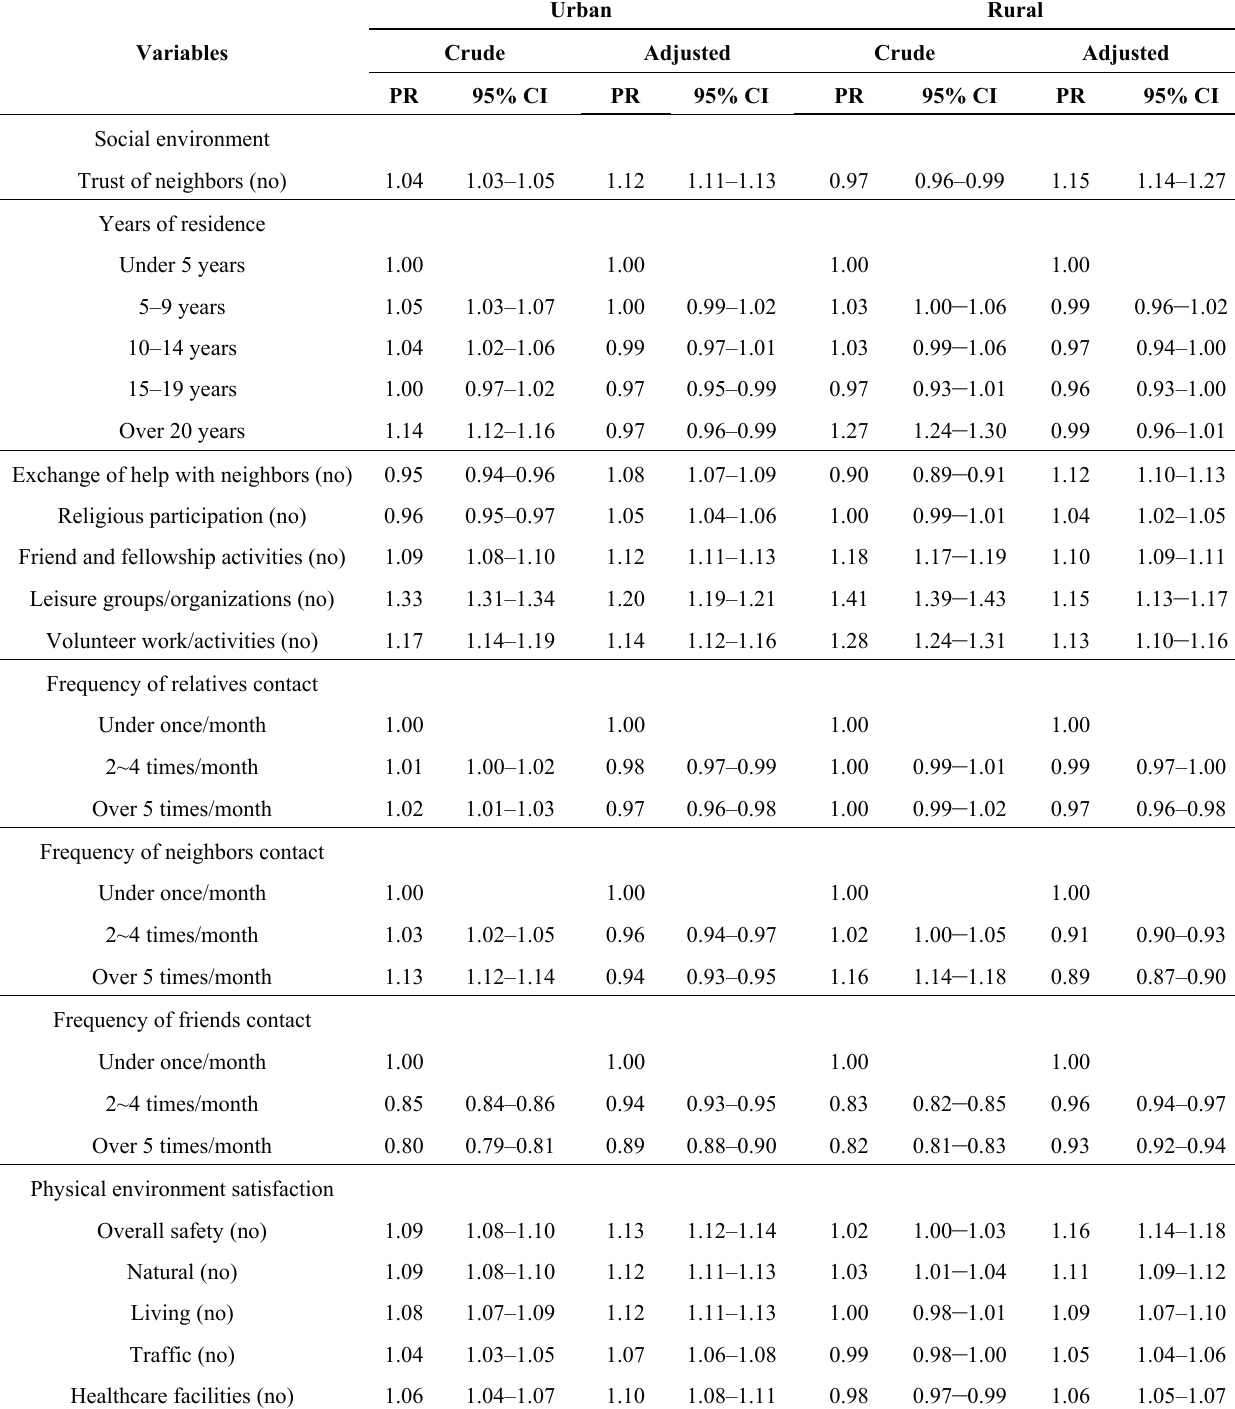
Table 3. Prevalence ratios (PRs) of social and physical environment factors and poor